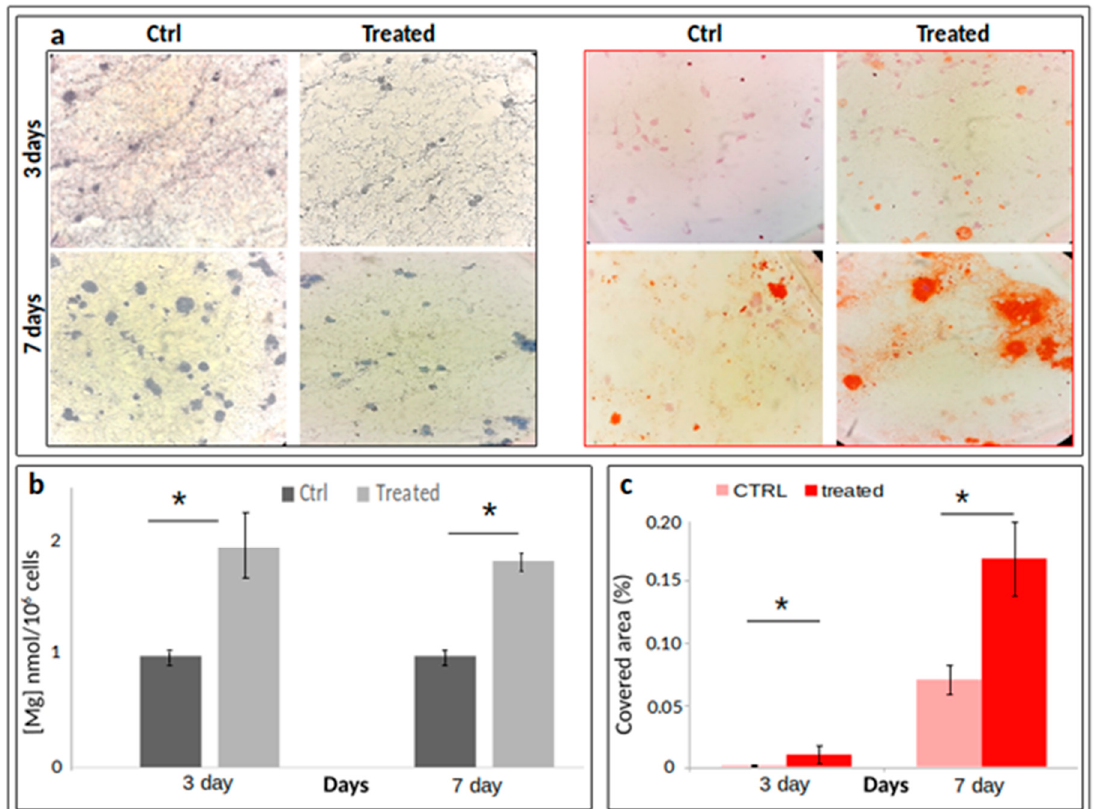
Figure 3. H/E ((a), left panel) or Alizarin Red ((a), right panel) staining of paraffin-embedded sections of 10 µm thickness ( n = 3). (b) Fluorimetric assay of total intracellular magnesium content by DCHQ5 probe (panel b) [19]; panel (c) quantification of Alizarin-stained Ca depositions. Data are reported as means ± standard error of the mean, values deriving from a triplicate experiment. * p < 0.05.